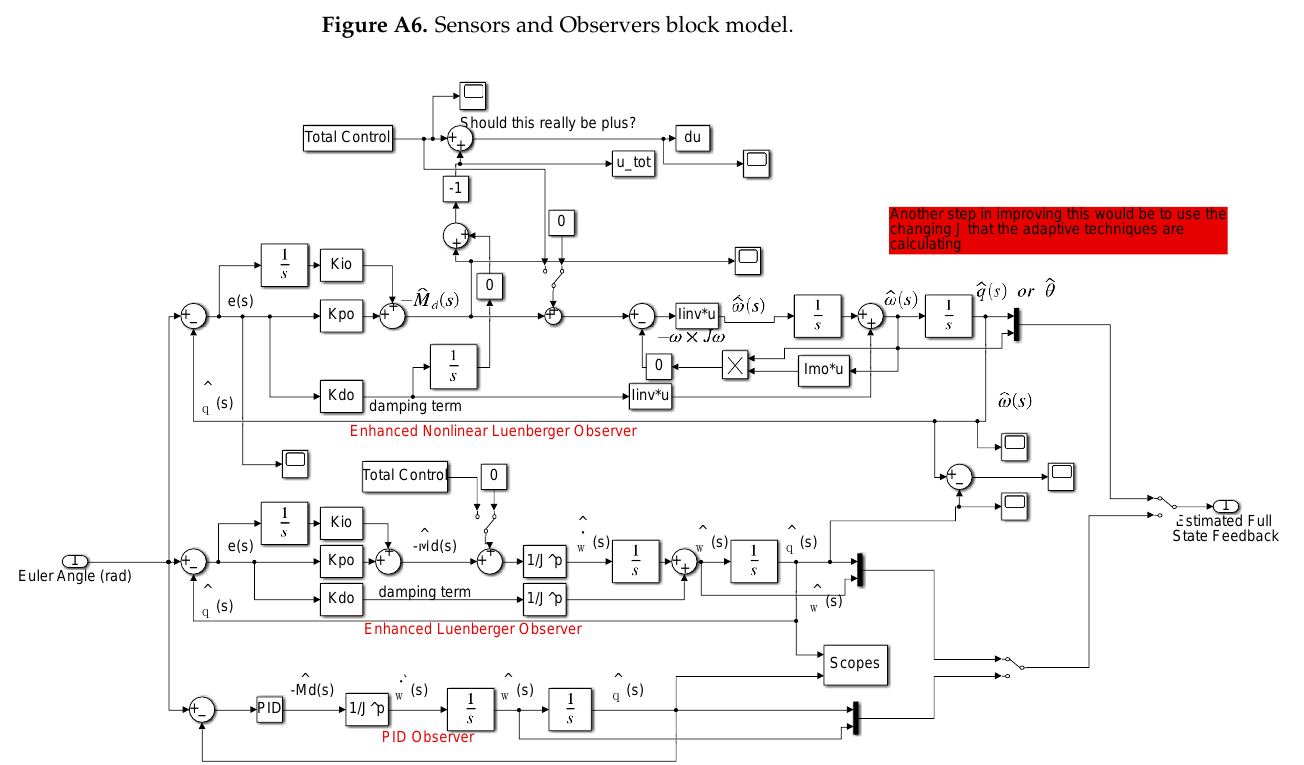
Figure A7. Luenberger Observer block model.